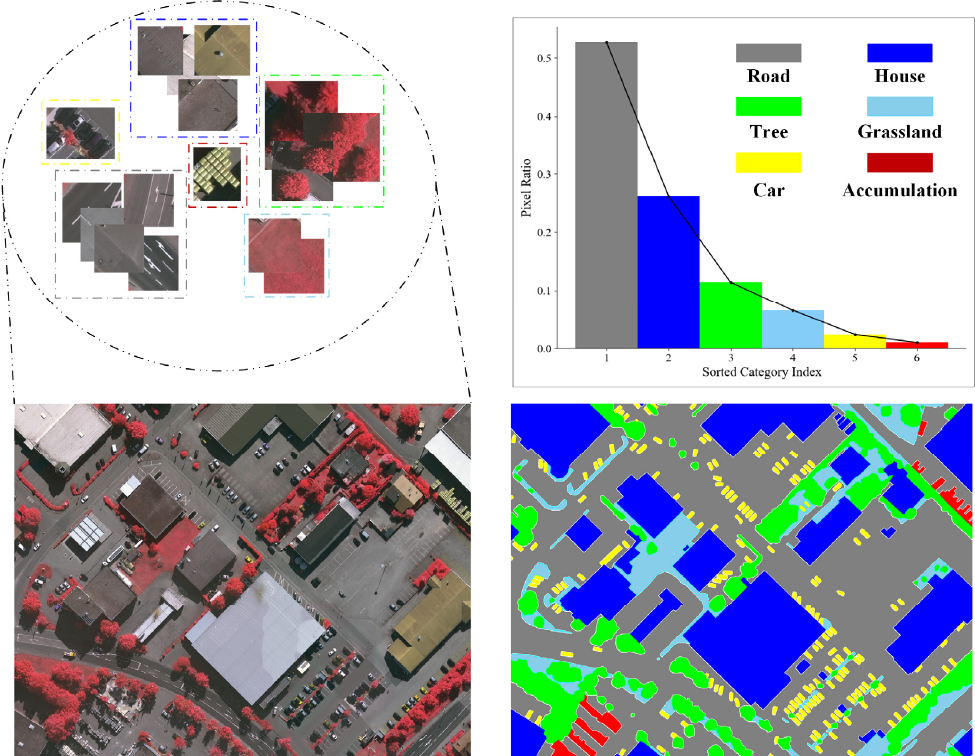
Figure 1. The distribution chart of the six main remote ‐ sensing objects in the urban scenario. It can be seen from the figure that the percentages of different kinds of remote ‐ sensing objects obviously obey a long ‐ tailed